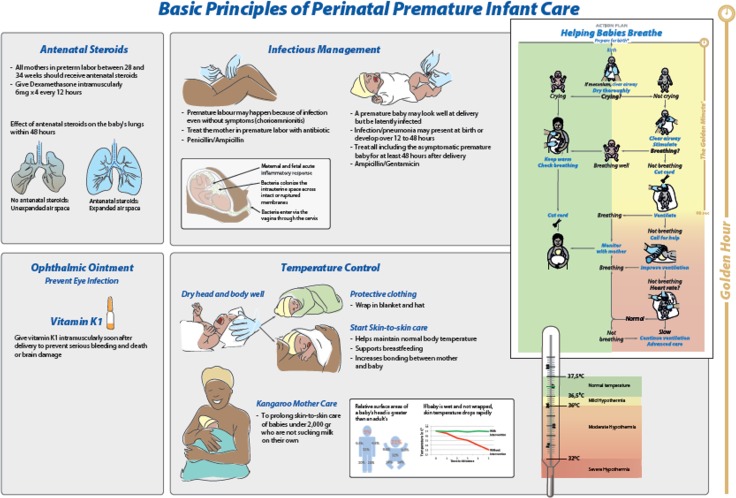
Flow diagram depicting the interventions to be applied in the bundle of care treatment strategy.